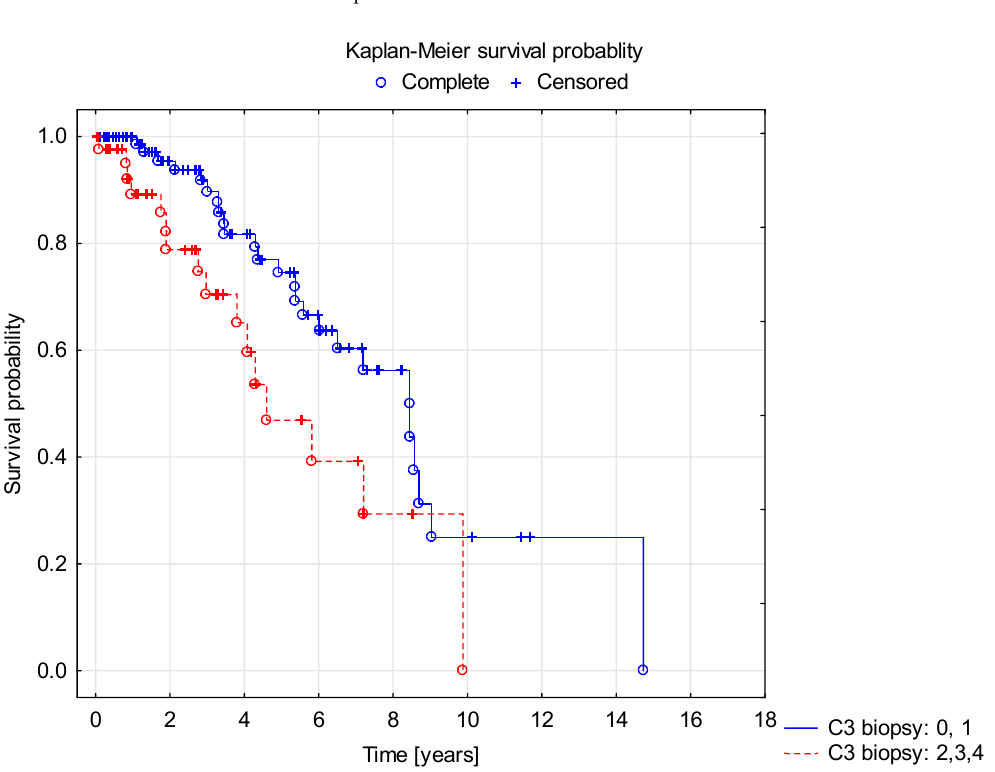
Figure 2. Shorter renal survival with normal GFR in Group B (intensity of C3 deposits = +2, +3, +4) vs. Group A (intensity of C3 deposits = 0, +1).